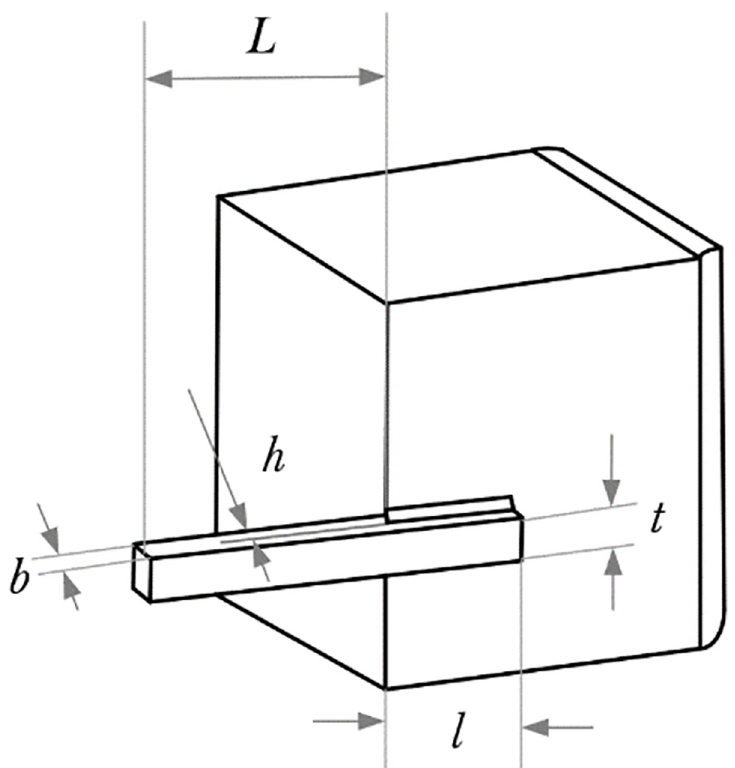
Fig 8. Design parameters of the welded beam design